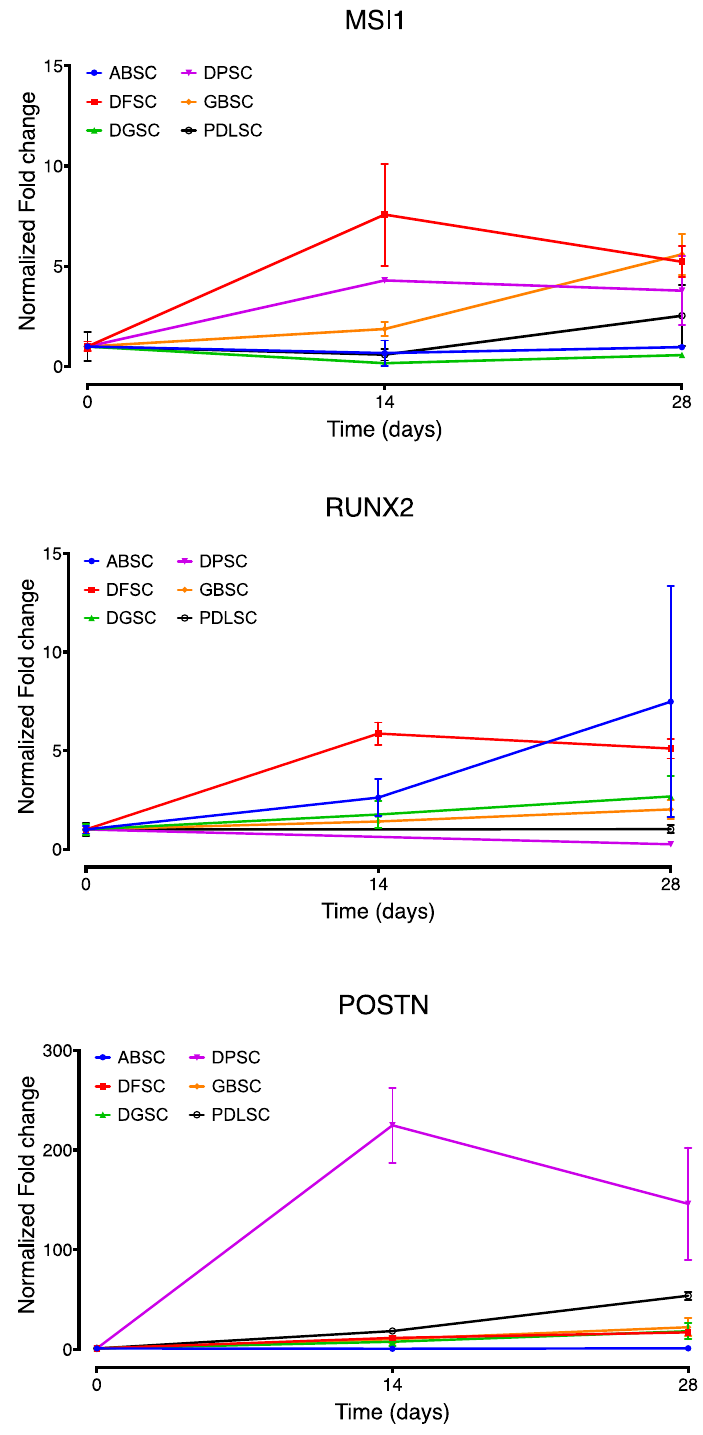
Figure 7. Comparative expression (fold change normalized to day 0) of MSI1, RUNX2, and POSTN over time by all cell populations under osteogenic conditions. Data are shown as mean(SD). When comparing the relative gene expression of MSI1, RUNX2, and POSTN within each cell population, there was a statistically significant differential expression of MSI1 and RUNX2 only in ABSC (28 days; p = 0.024). In all other cell populations, MSI1 and RUNX2 followed a comparable